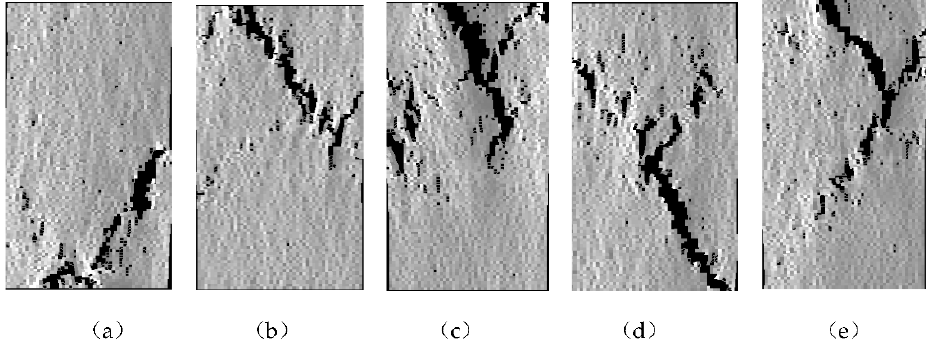
Figure 13. Deformation and rupture of coal samples under different gas pressure conditions: ( a ) the gas pressure is 0 MPa and the loading step is 68; ( b ) the gas pressure is 0.5 MPa and the loading step is 65; ( c ) the gas pressure is 1 MPa and the loading step is 63; ( d ) the gas pressure is 1.5 MPa and the loading step is 60; ( e ) the gas pressure is 2 MPa and the loading step is